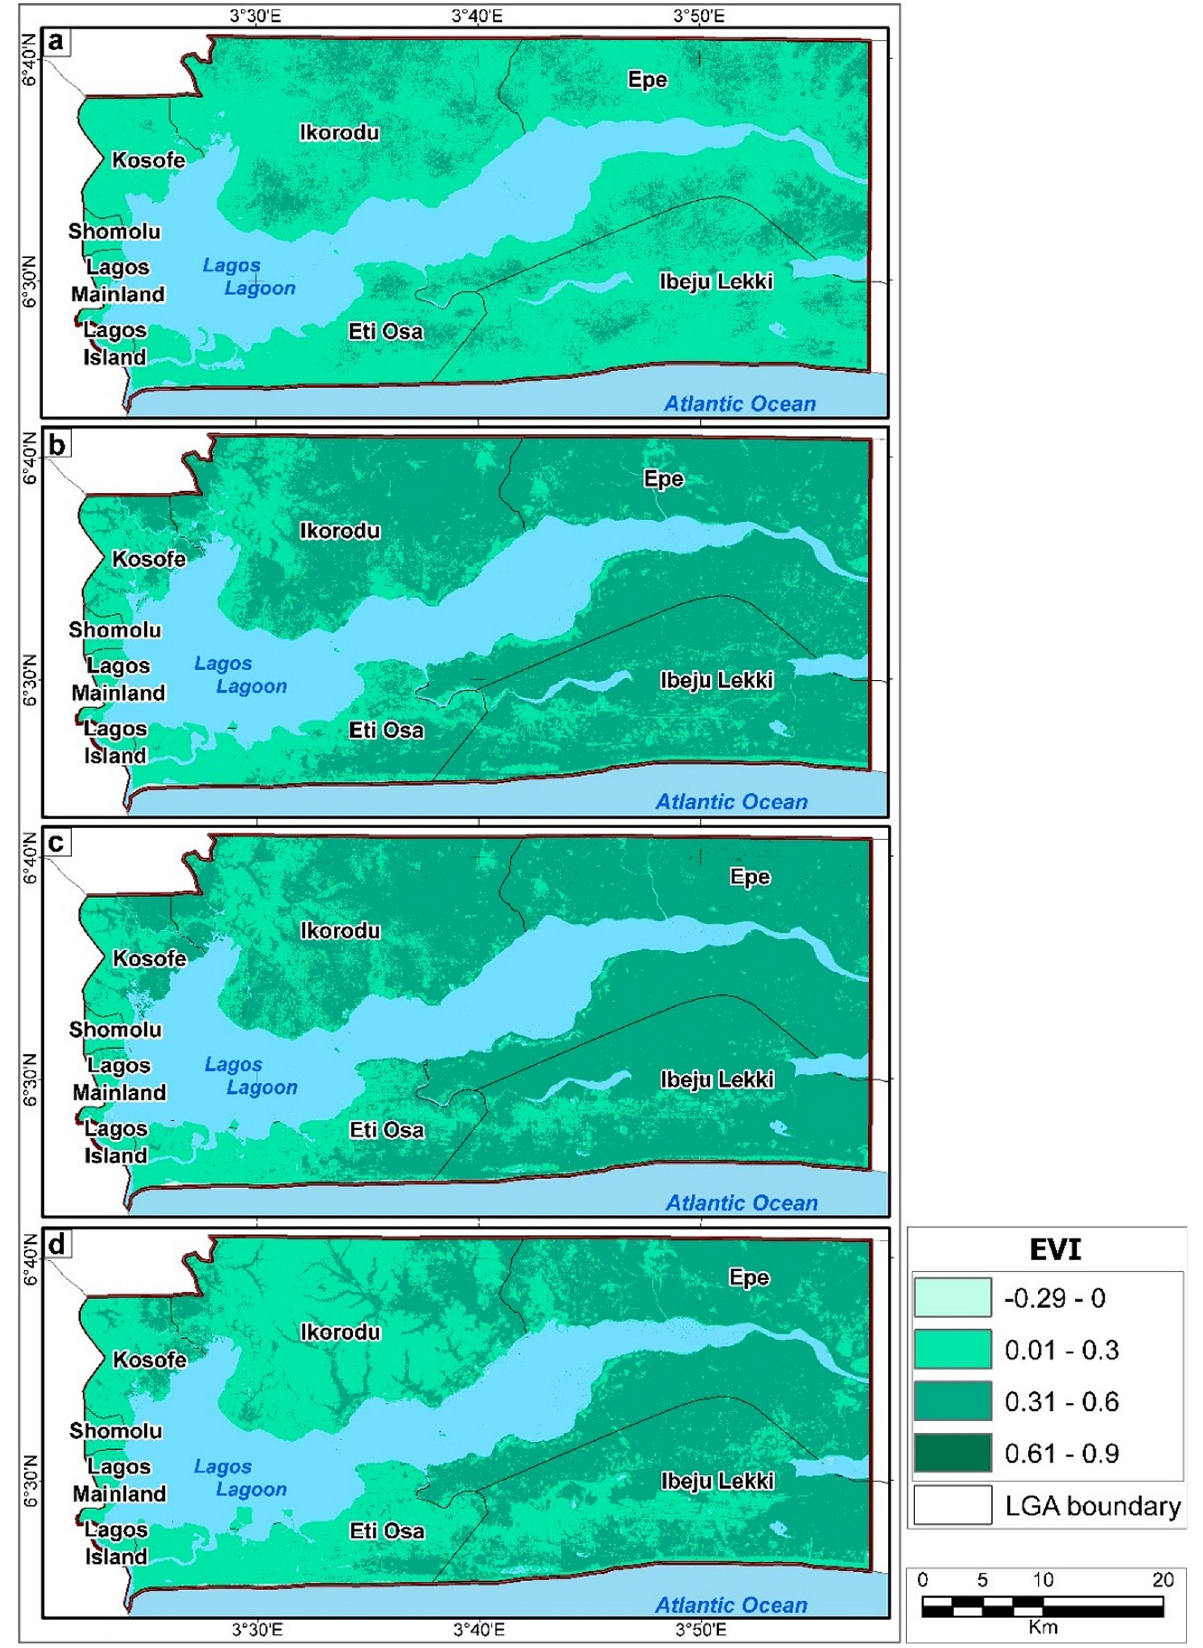
Fig. 7. Spatial pattern of EVI for 1984 (a), 2002 (b), 2013 (c) and 2019